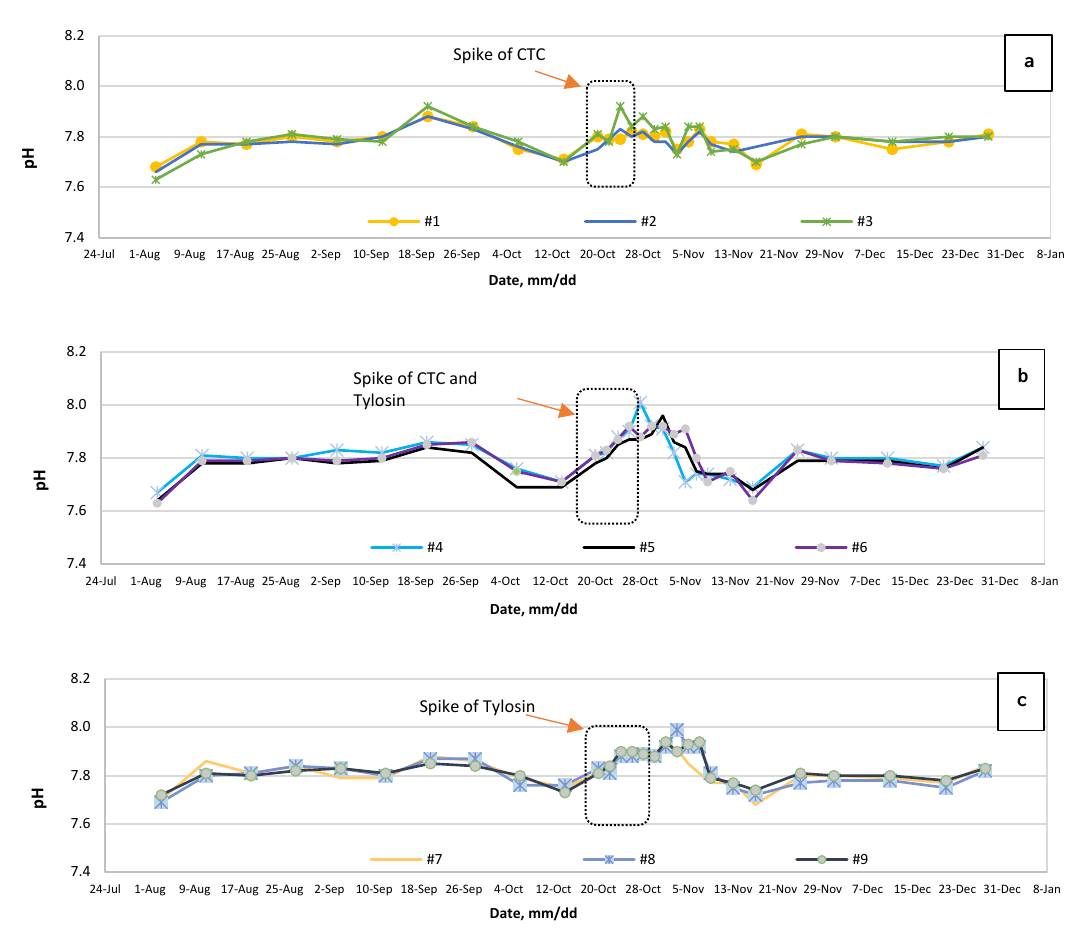
Figure 3. Digestate pH levels for ( a ) before and after CTC spike, ( b ) before and after CTC plus tylosin spike, and ( c ) before and after tylosin spike and the dotted box shows the administration period of the VAs.